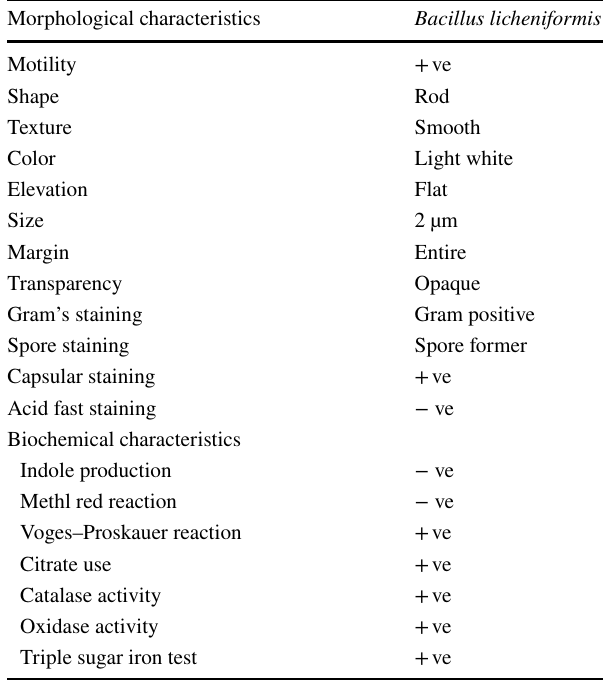
Table 1 Morphological and biochemical characteristics of Bacillus